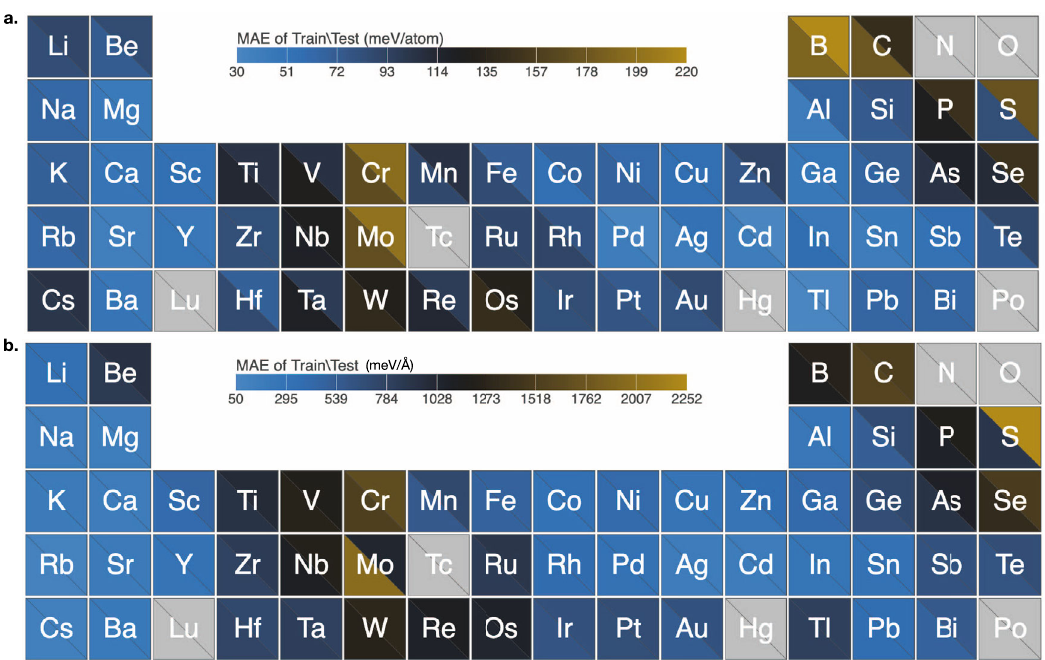
Fig. 2 HyBOP model performance after high-throughput exploration of the potential energy surface of nanoclusters using continuous action MCTS. A bond-order model with Tersoff-type formalism for 54 different elements across the periodic table is parameterized using an extensive training dataset generated from density functional theory (DFT) computations. The training set includes nanoclusters of varying sizes and shapes (~1500 con fi gurations and their energies) for each of the different elements. Mean absolute error (MAE) in a energy and b force predictions of the bond-order force fi elds relative to the reference DFT model on a test set of ~70,000 con fi gurations is shown using the color bar in meV/atom and meV/Å units,